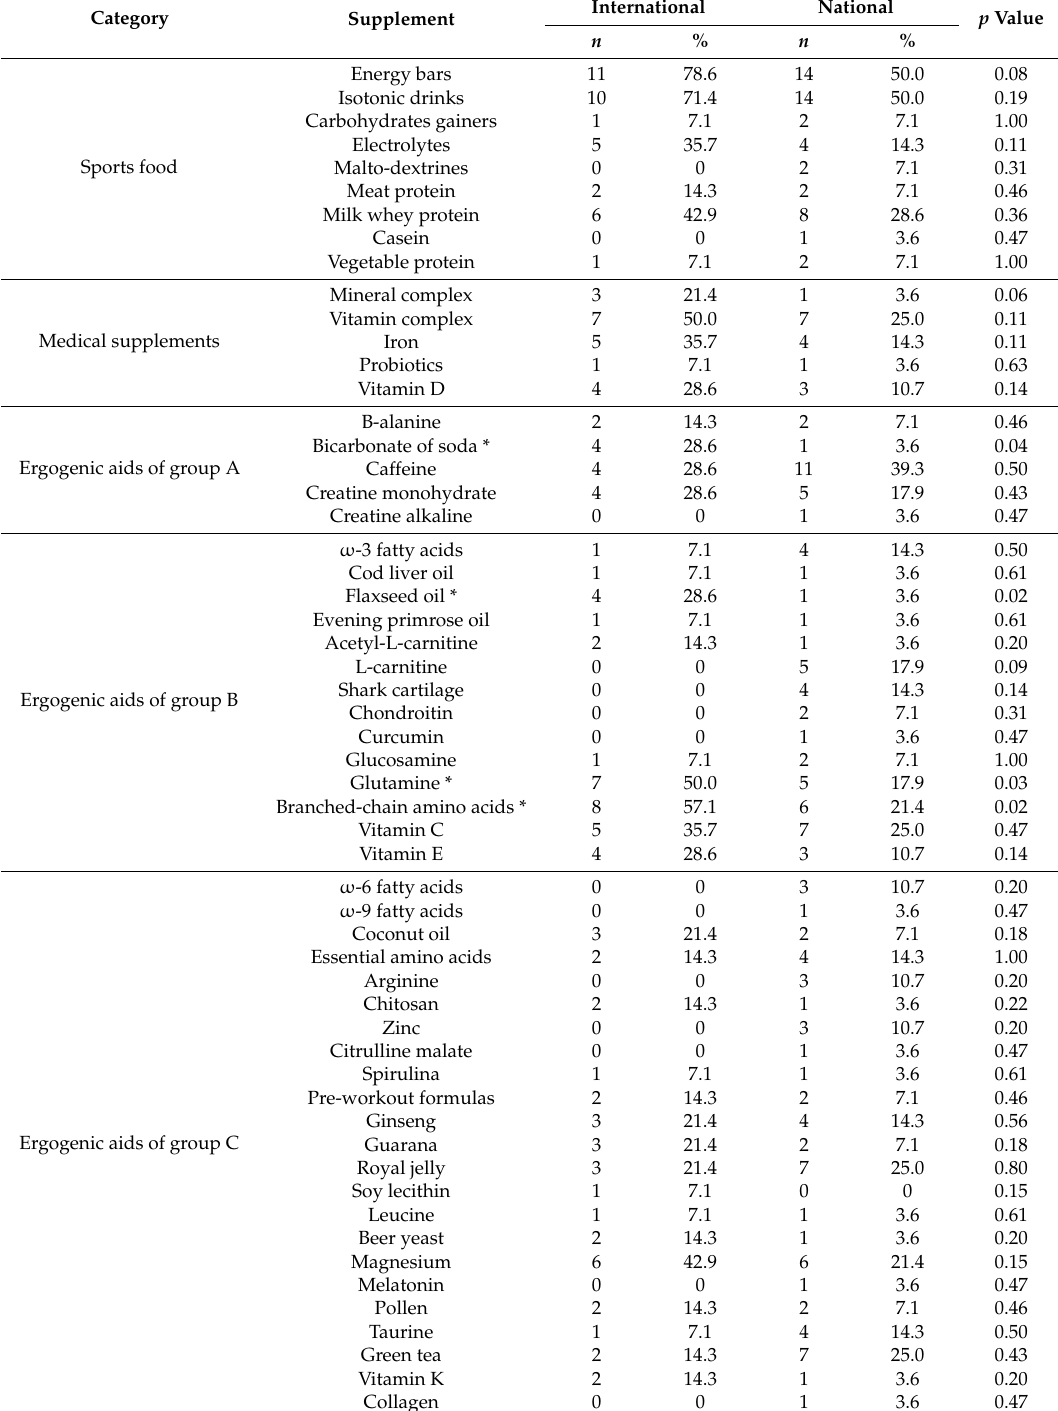
Table 2. Consumption of nutritional supplements by international-level and national-level athletes in the different categories established by Australian Institute of Sport